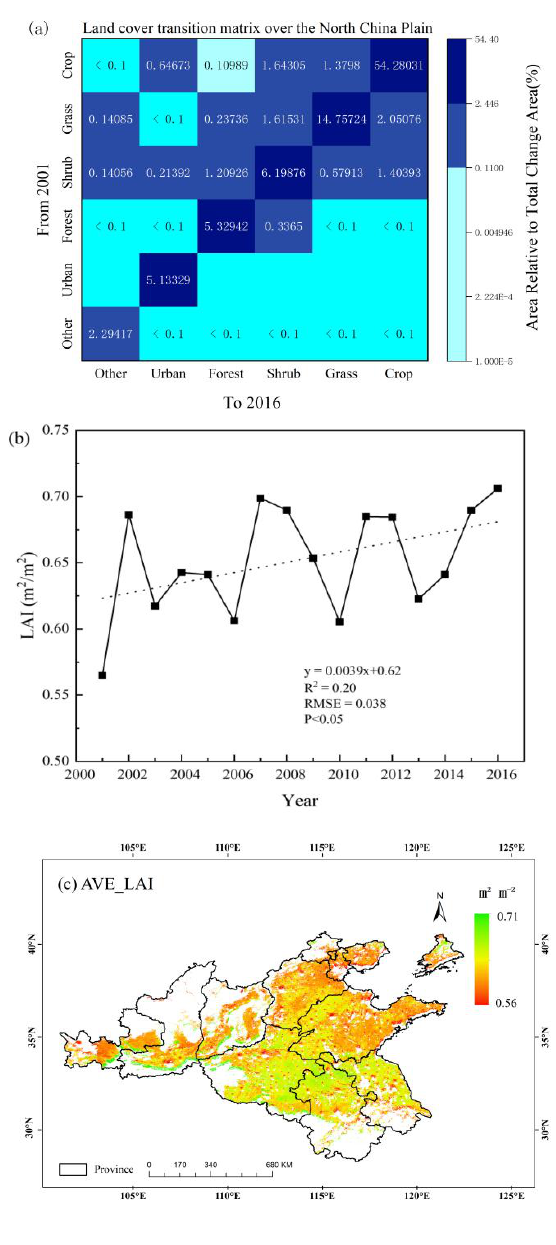
Figure 2 . (a) is Land cover transition matrix over the North China Plain (b) is interannual trends of LAI in the North China Plain and (c) is a spatial distribution of average LAI in the North China Plain from 2001 to 2016 (The redder part of the figure indicates a lower LAI value. The greener part indicates a higher LAI value).